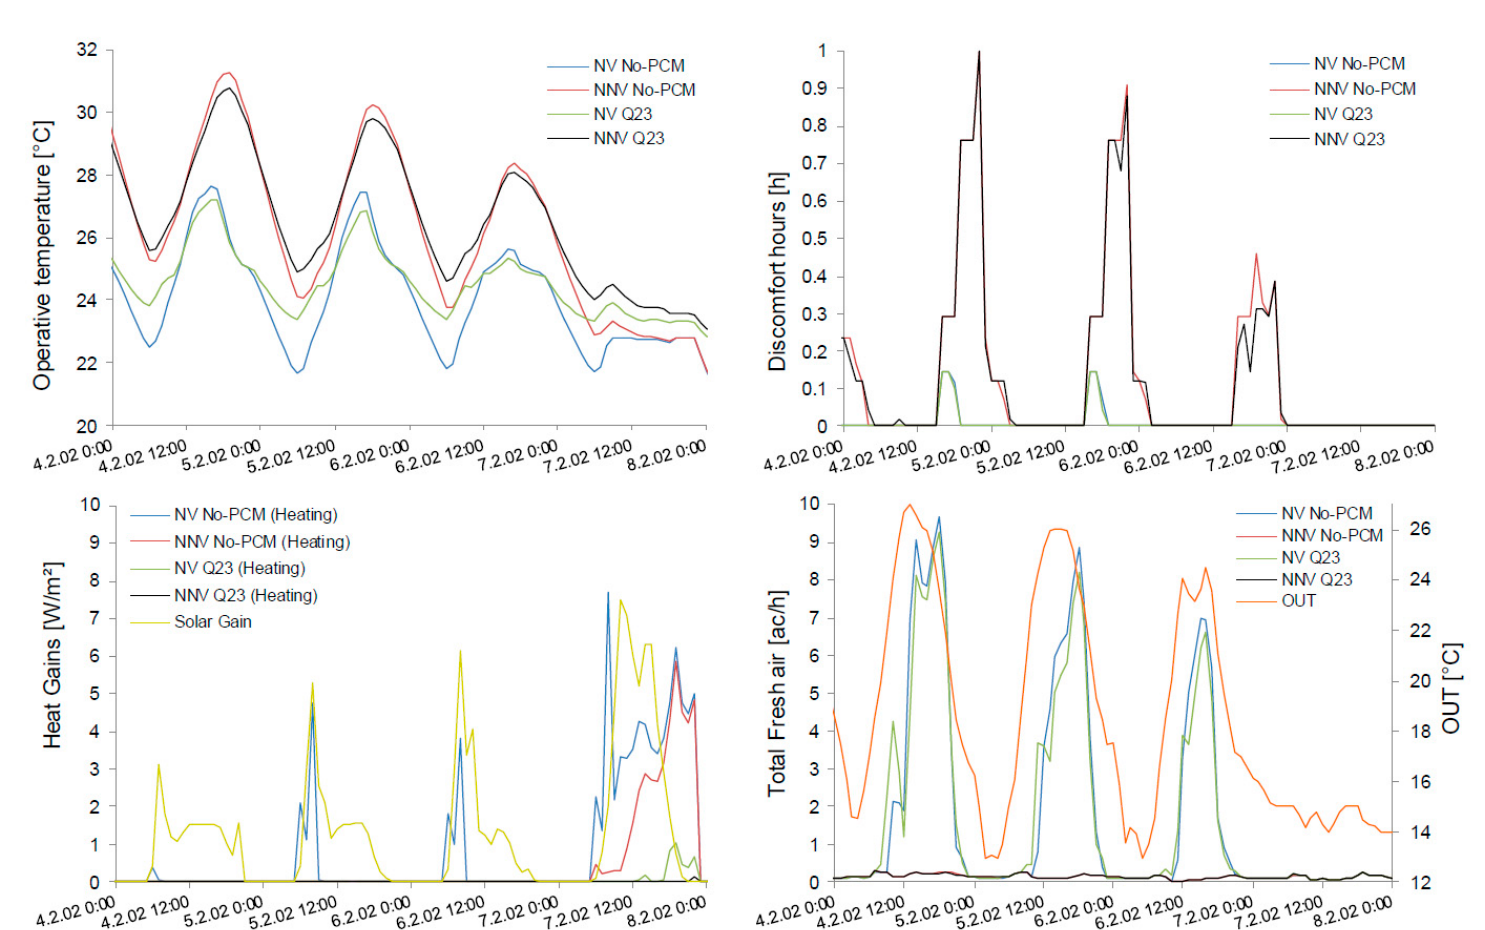
Figure 8. Operative temperature ( top left ), heat gains ( bottom left ), discomfort hours ( top right ), and total fresh air ( bottom right ) for 4–7 February (summer days) for building A.